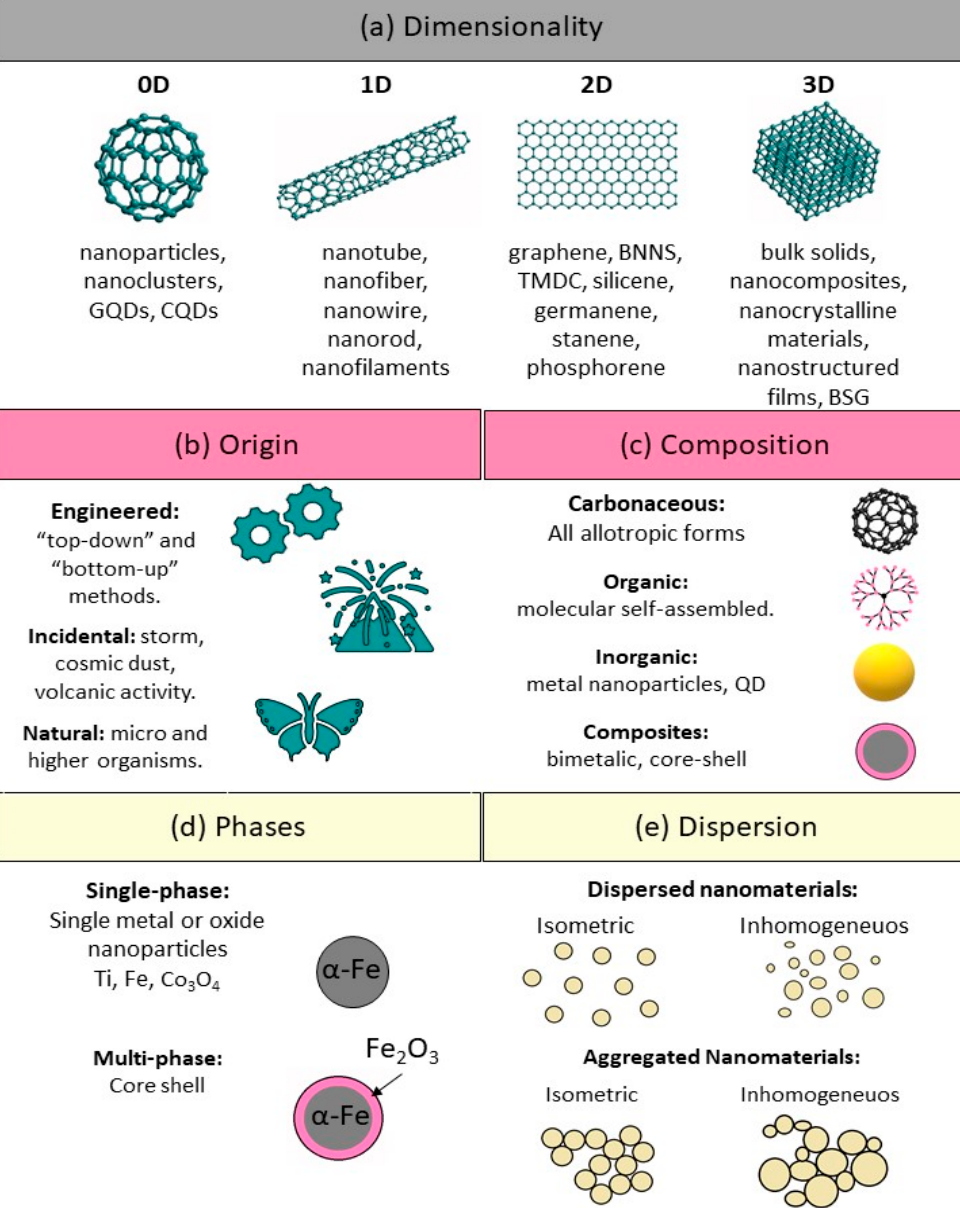
Figure 7. Classification of nanoparticles in function of their ( a ) dimensionality, ( b ) origin, ( c ) composition, ( d ) phases, and ( e ) dispersion. Abbreviations are Graphene quantum dots (GQDs); Carbon quantum dots (CQDs); BNNS: Boron Nitride Nano Sheets; Monolayer transition metal dichalcogenides (TMDCs); basil seed gum nanoparticles (BSG NPs); Quantum dots (QDs); Titanium (Ti); Ferric oxide (Fe 2 O 3 ); Cobalt tetraoxide (Co3O4).